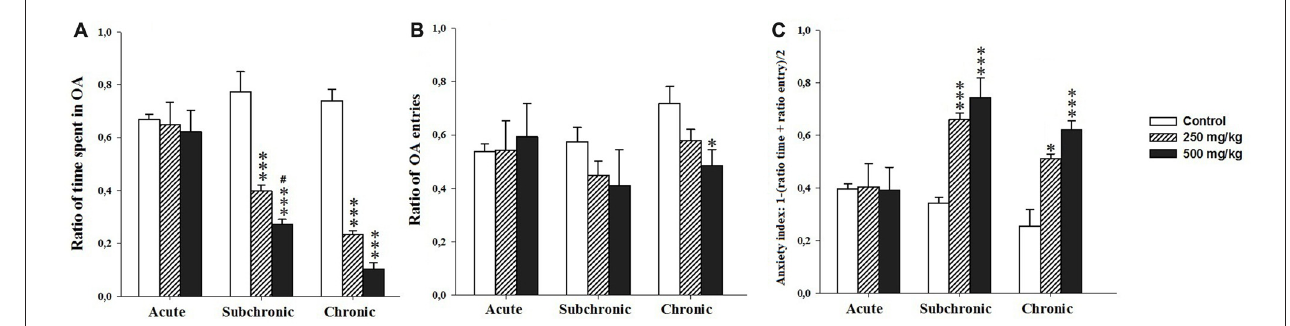
FIGURE 3 | Effect of the acute and repeated exposures to GBH on anxiety-like behavior. (A) The ratio of time spent in open arm. (B) The ratio of open arm entries. (C) The anxiety index. Ratio = time spent in each arm/(time spent in open arm + time spent in closed arm). Results are presented as mean ± SEM. ∗ P < 0.05; ∗∗∗ P < 0.001. The ∗∗∗ refers to the control vs. 250 mg/kg and 500 mg/kg group comparison and the “#” refers to the 250 mg/kg vs. 500 mg/kg group comparison. # P < 0.05: the post hoc analysis.